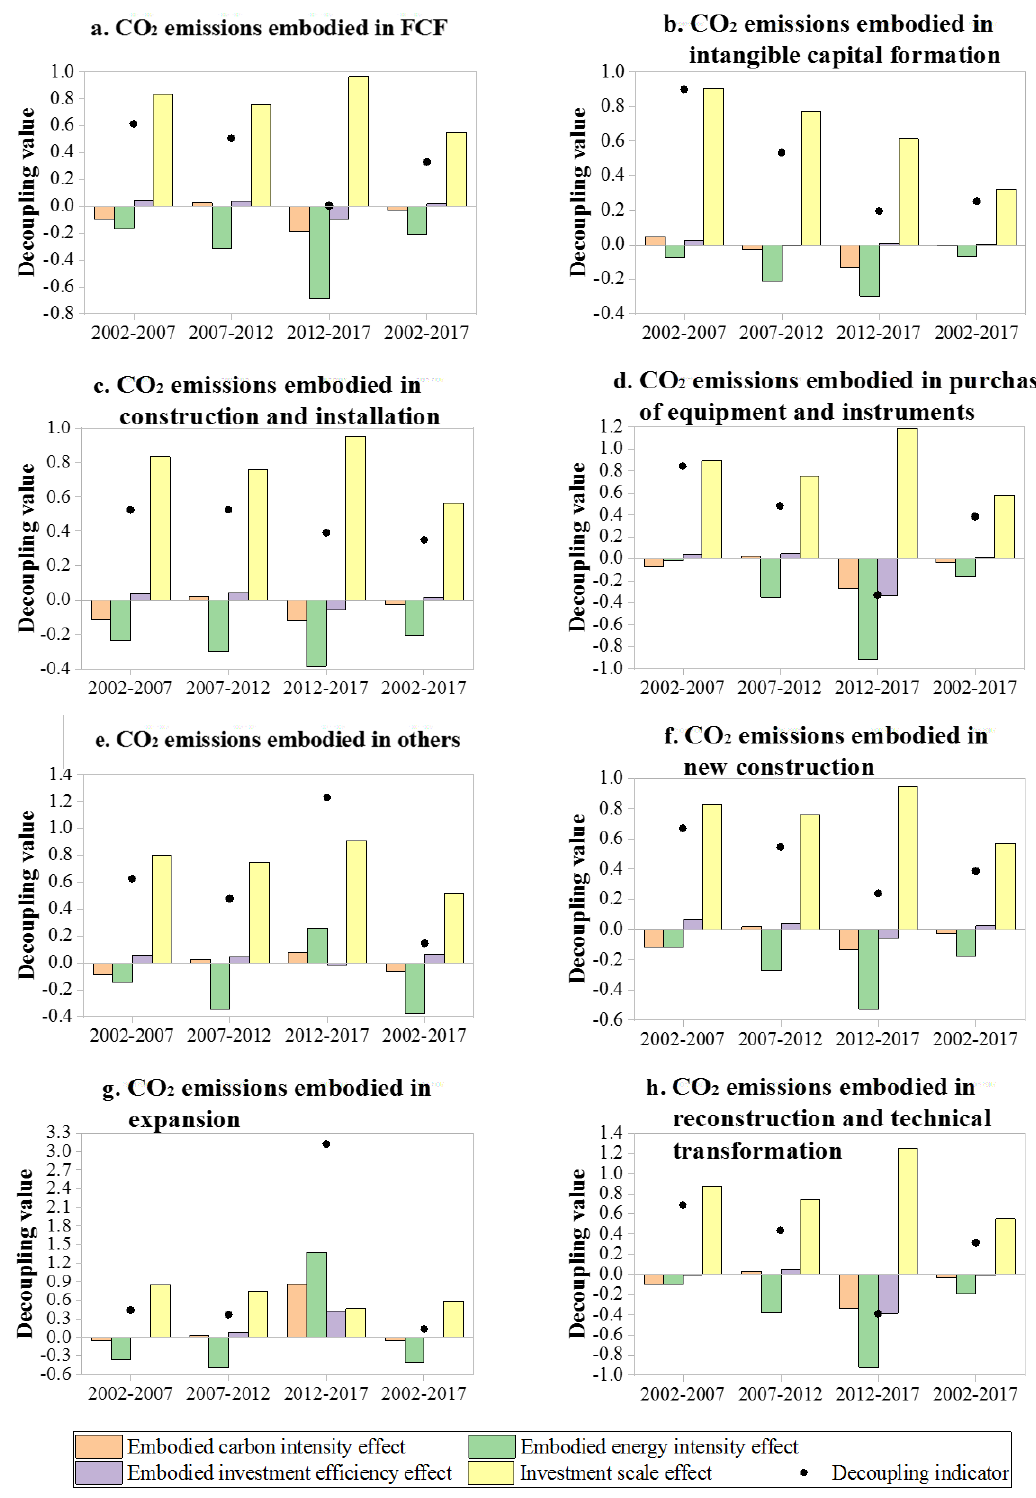
Figure 7. Decoupling states and driving forces of CO 2 emissions embodied in FCF and added value embodied in FCF. embodied in